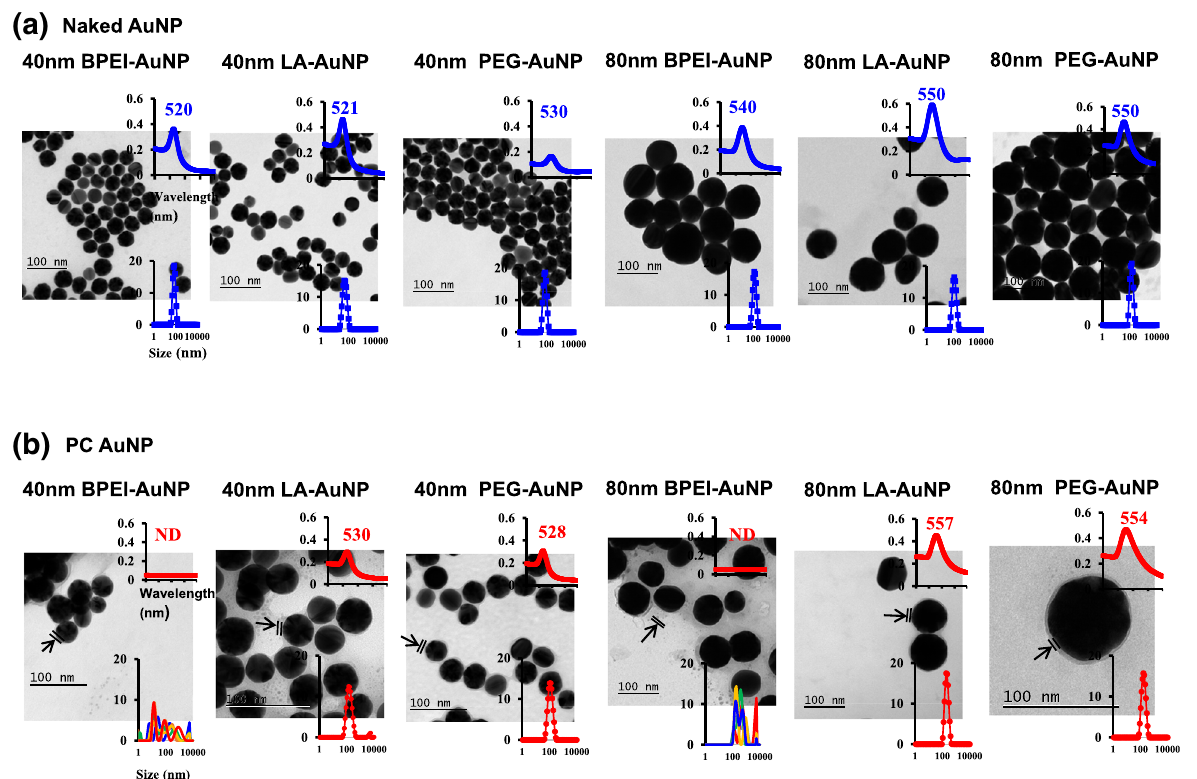
Fig. 1 Transmission electron micrographs of ( a ) the 40 and 80 nm naked AuNP in deionized water and b the 40 and 80 nm PC AuNP in PBS at 0 h at 25 °C, UV absorption spectrum (upper inset), and the dynamic light scattering distribution (lower inset). Arrows indicate PC formation. BPEI